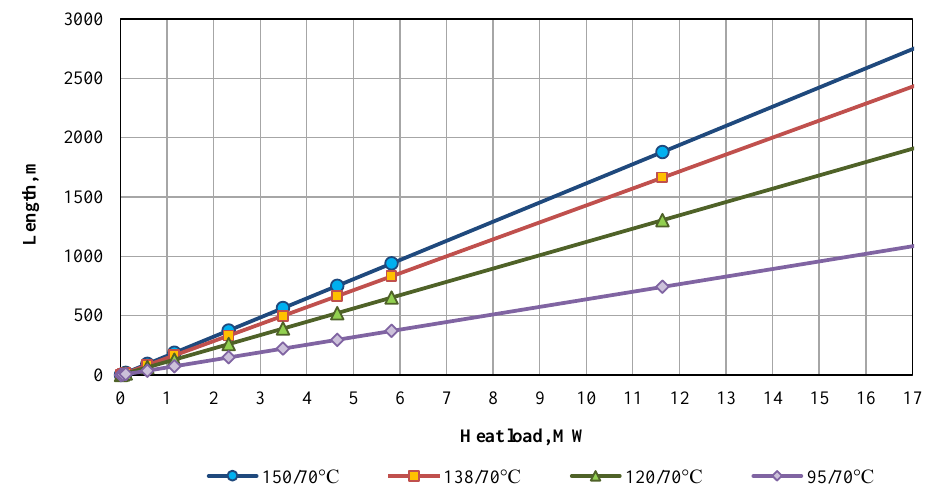
Fig. 4. The maximum length of a heat pipeline from the point of new consumer connection to the transmission pipeline of DHS based on NICHPP. In the event that the applicant is located in the zone of effective heat supply radius and wants to connect a 1.16 MW (1 Gcal/h) load to the heating system at a supply/return temperature of 120/70 °С, DHS company, based on connection effectiveness